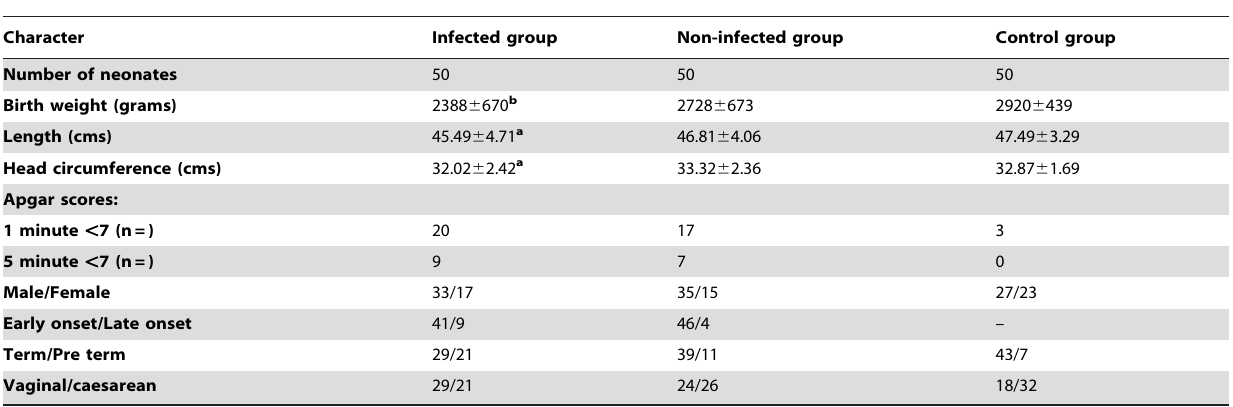
Table 1. Clinical characteristics of the study population.